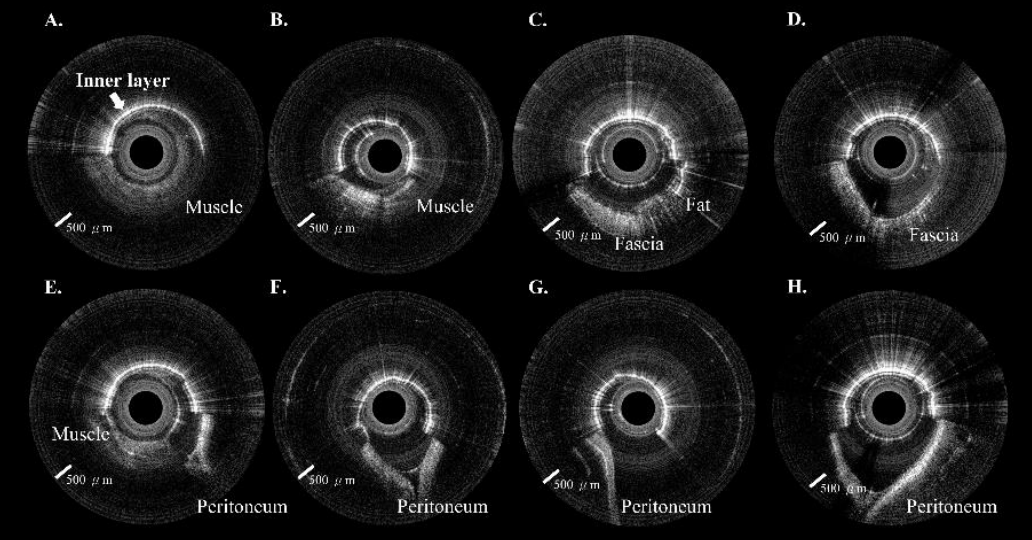
Figure 4. Veress needle probe punctured the midline of the abdomen. ( A – D ) Approximately half of the OCT image shows the extra-peritoneal tissue. ( E – H ) Approximately half of the OCT image shows the peritoneum.